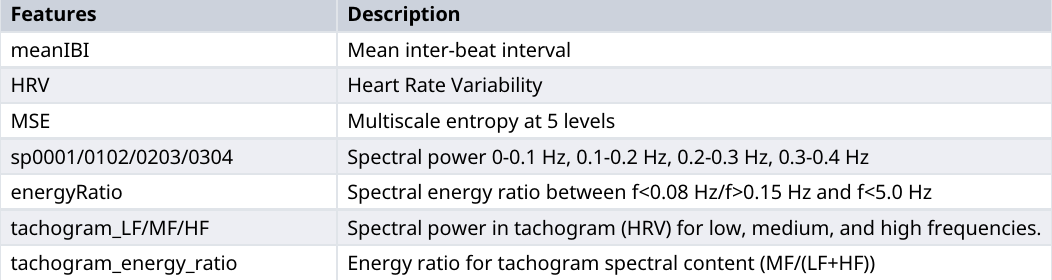
Table 4. Features extracted from Toolbox for Emotional feature extraction from Physiological signals